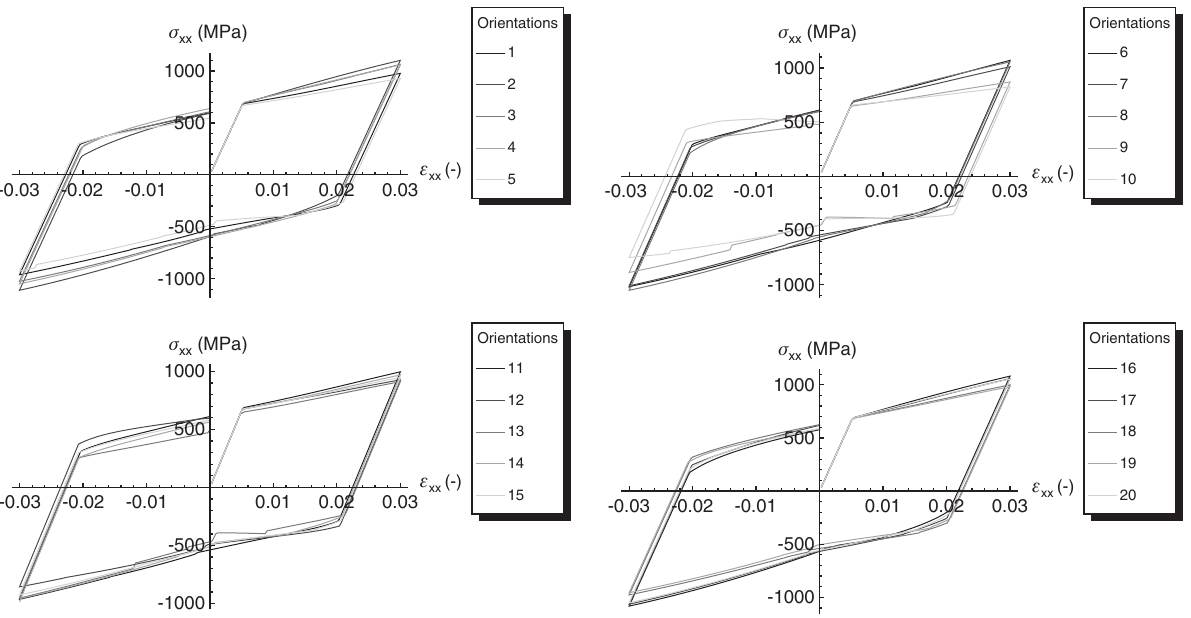
Figure 2: Stress/strain diagrams for the respective